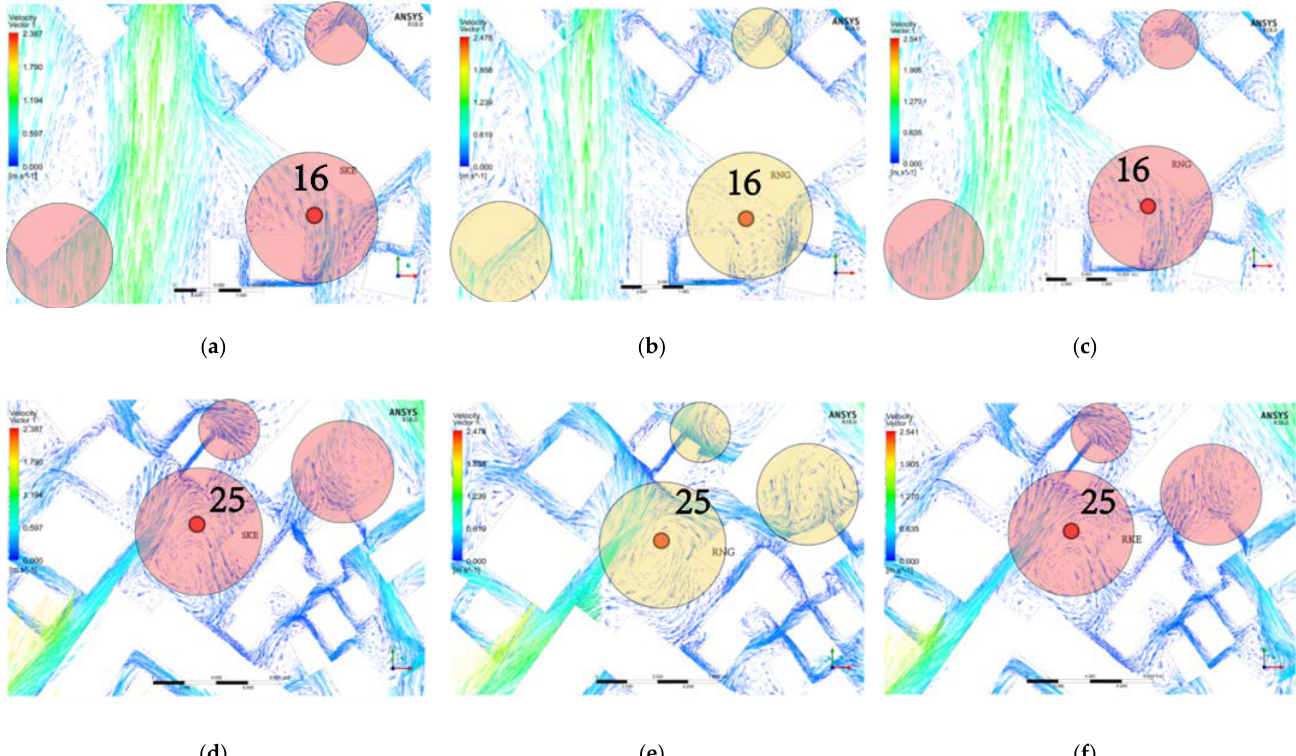
Figure 12. SKE-, RNG-, and RKE-simulated wind environment distribution at points 16 and 25. ( a ) SKE-simulated wind environment distribution at point 16. ( b ) RNG-simulated wind environment distribution at point 16. ( c ) RKE-simulated wind environment distribution at point 16. ( d ) SKE-simulated wind environment distribution at point 25. ( e ) RNG-simulated wind environment distribution at point 25. ( f ) RKE-simulated wind environment distribution at point 25.